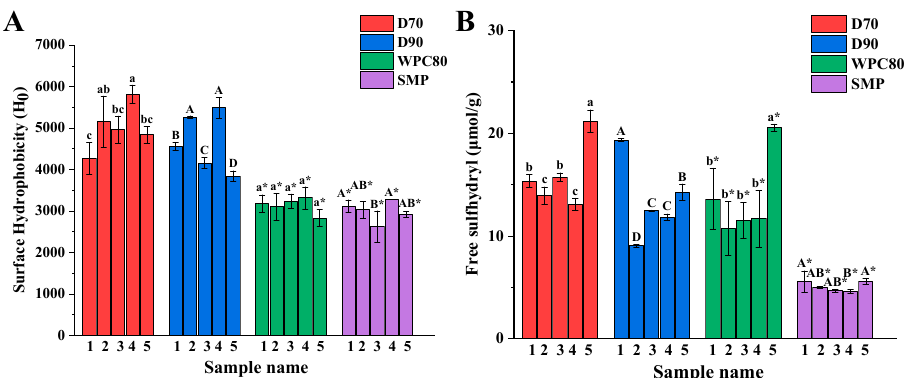
Figure 5. Surface hydrophobicity ( A ) and free sulfhydryl content ( B ) of D70, D90, WPC, and SMP samples from different manufacturers. (a–c, A–D, a*–b*, A*–B*) indicate significant differences at p < 0.05.